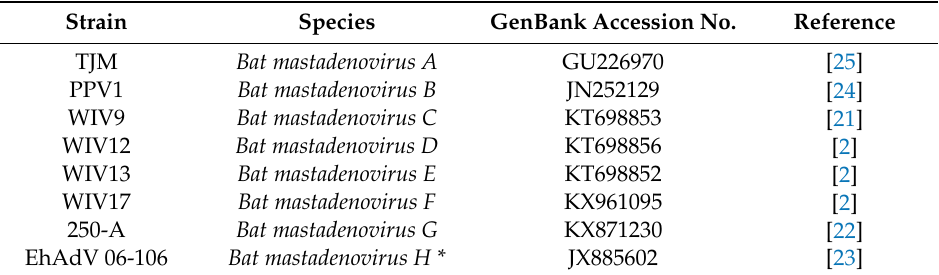
Table 1. Classification (2018) of bat mastadenovirus species proposed by ICTV. Strain Species GenBank Accession No. Reference TJM Bat mastadenovirus A GU226970 PPV1 Bat mastadenovirus B JN252129 WIV9 Bat mastadenovirus C KT698853 WIV12 Bat mastadenovirus D KT698856 WIV13 Bat mastadenovirus E KT698852 WIV17 Bat mastadenovirus F KX961095 250-A Bat mastadenovirus G KX871230 EhAdV 06-106 Bat mastadenovirus H * JX885602 * Candidate novel